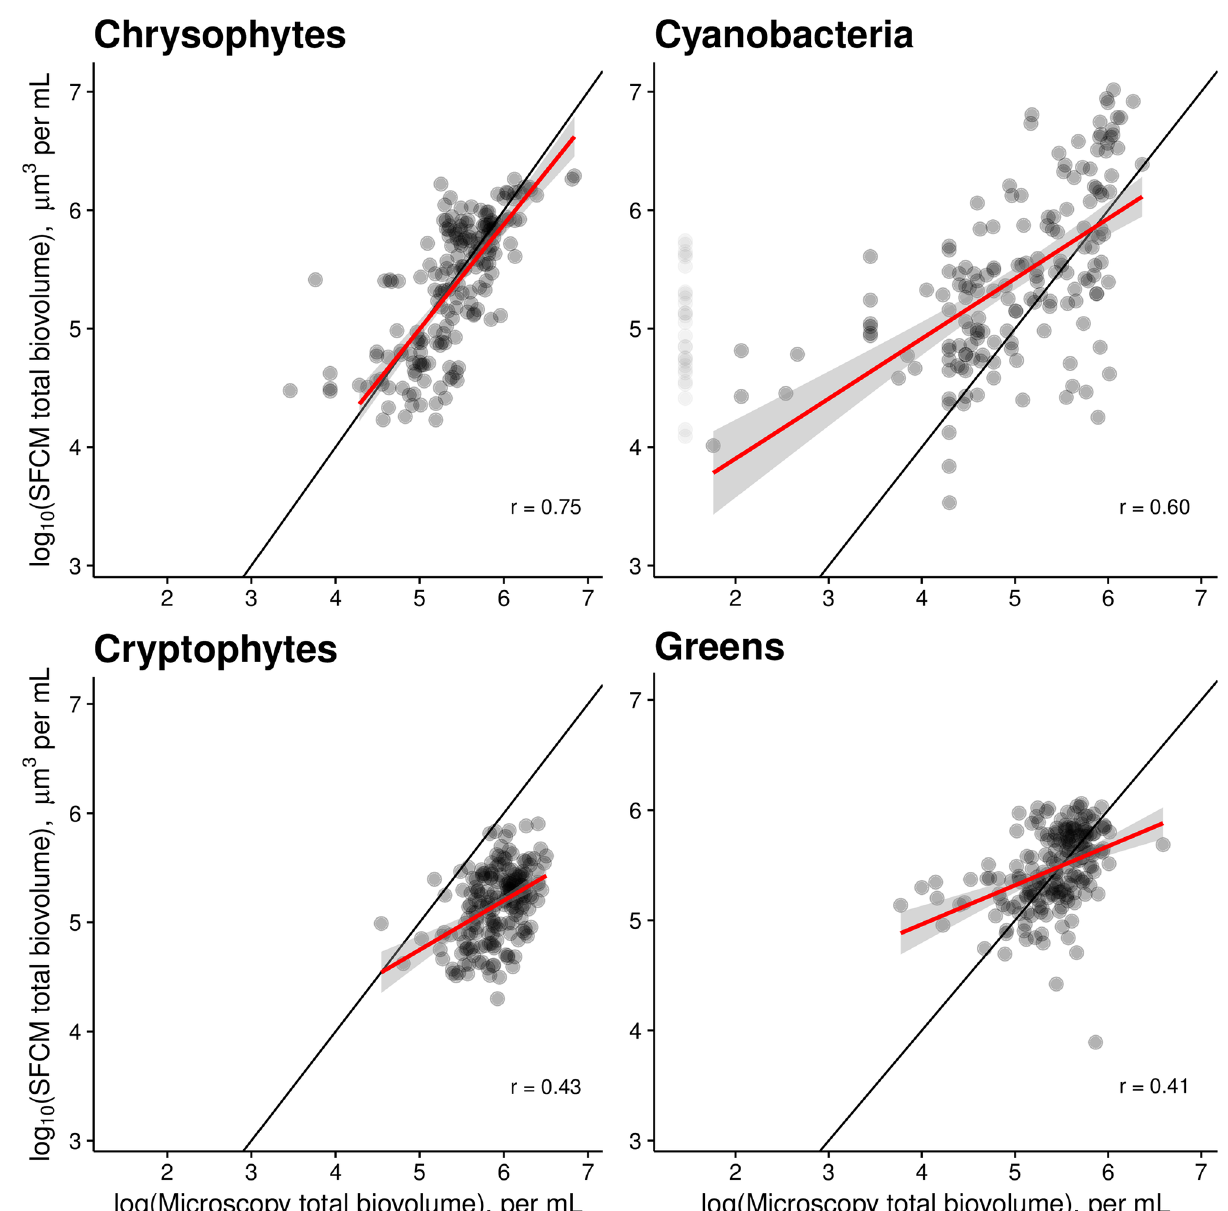
Fig 5. Total biovolume estimates of major functional groups are similar when measured by SFCM or microscopy. Estimates of total biovolume of four functional groups by SFCM and microscopy are moderately well-correlated on the log scale (r between 0.41 and 0.75, p < 0.001 in all cases). Each point represents a single depth-specific sample measured using both methods. The black line is the 1:1 line and the red line represents the regression relationship (with confidence bands). In a small number of microscopy measurements, no cyanobacteria were found. These points are plotted with high transparency assuming that the true concentration was half the minimum cyanobacterial biovolume detected. A small number of high-leverage points were excluded from the regressions, but the effect of this exclusion on slopes and correlation coefficients is modest. These excluded points can be identified in the plots because the regression lines do not extend to